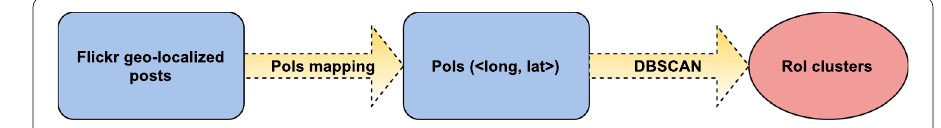
Fig. 8 Structure of the proposed Hive